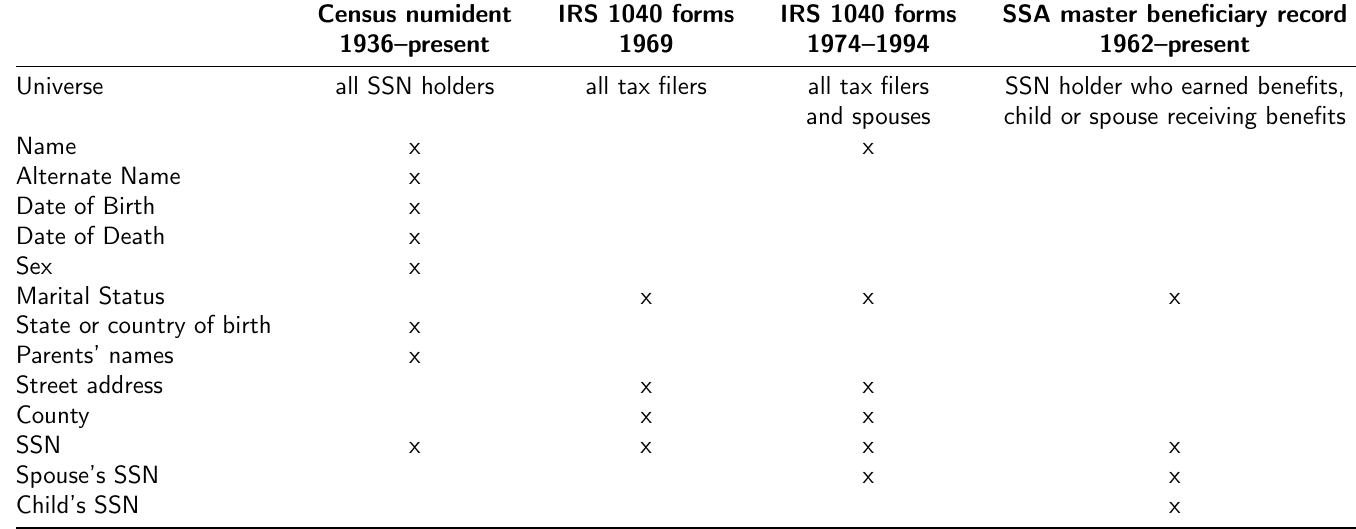
Table 1: Data sources used to construct the administrative records composite